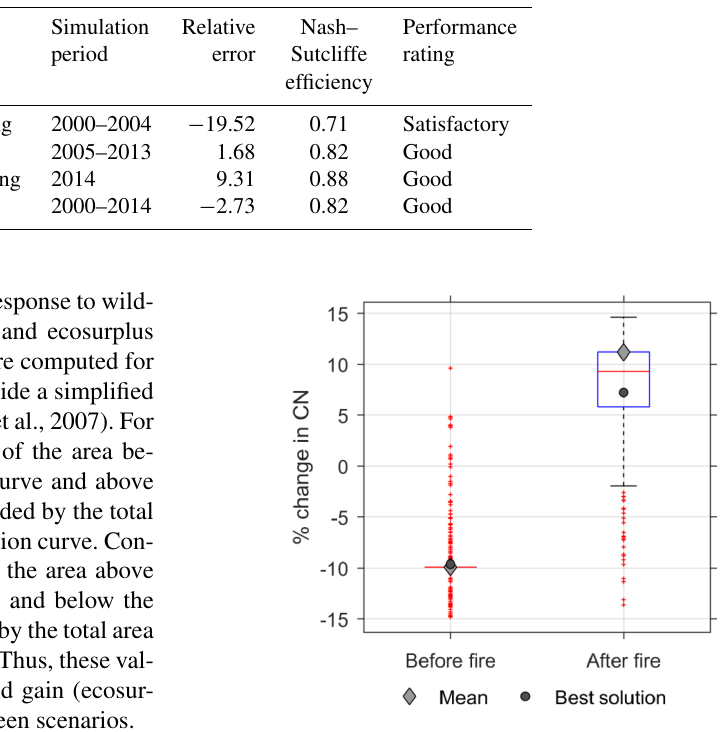
Figure 3. Box plots showing the range of % change in CNs for before and after fire conditions (the boxes show the range of values between 25th and 75th percentiles; the whiskers show the 0.5 and 99.5